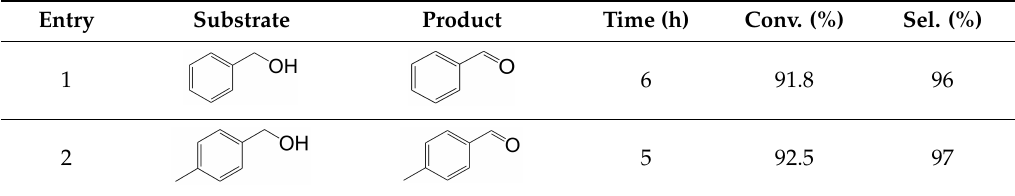
Table 2. Photocatalytic oxidation of various benzylic alcohols over